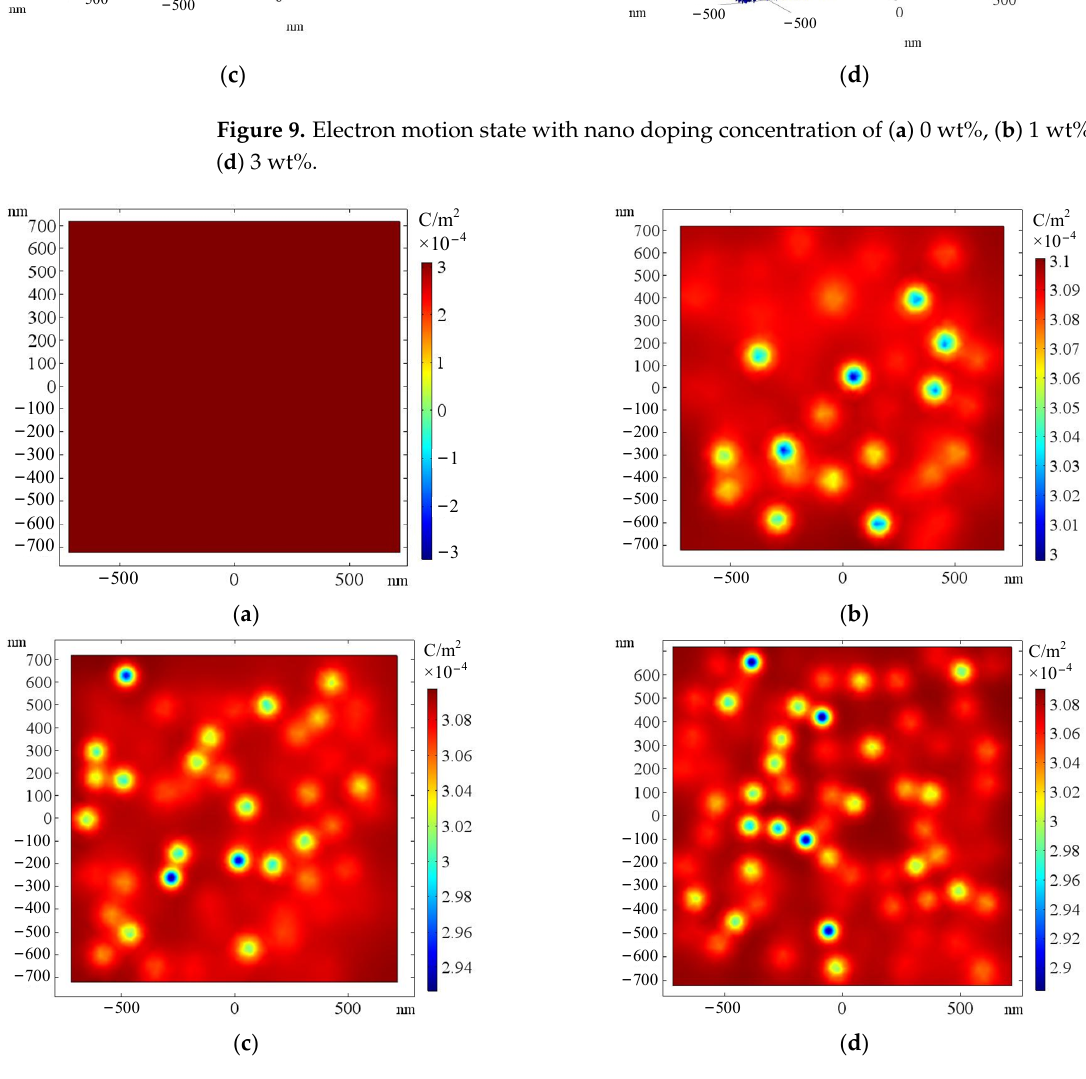
Figure 10. The nanoSiO 2 -doping concentration is ( a ) 0 wt%, ( b ) 1 wt%, ( c ) 2 wt%, ( d ) 3 wt% anode surface charge density. Table 8. The average surface space charge density of pure epoxy resin and SiO 2 /epoxy resin nano- dielectric.